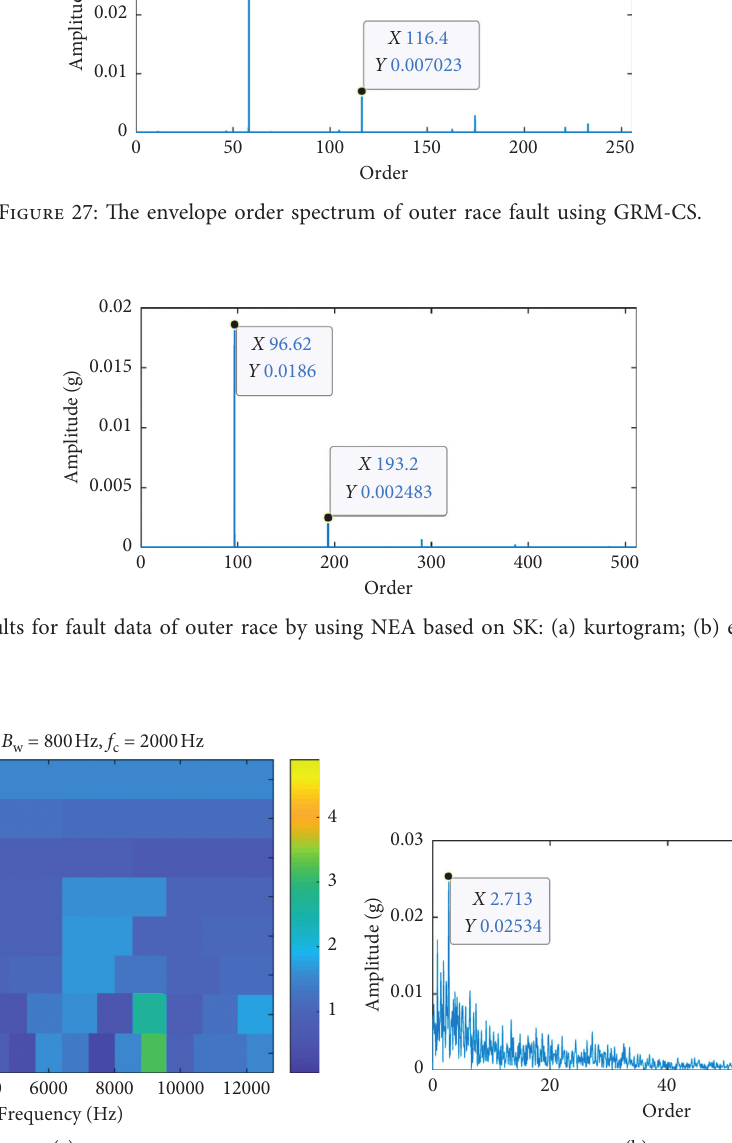
Figure 29: The envelope order spectrum of inner race fault using